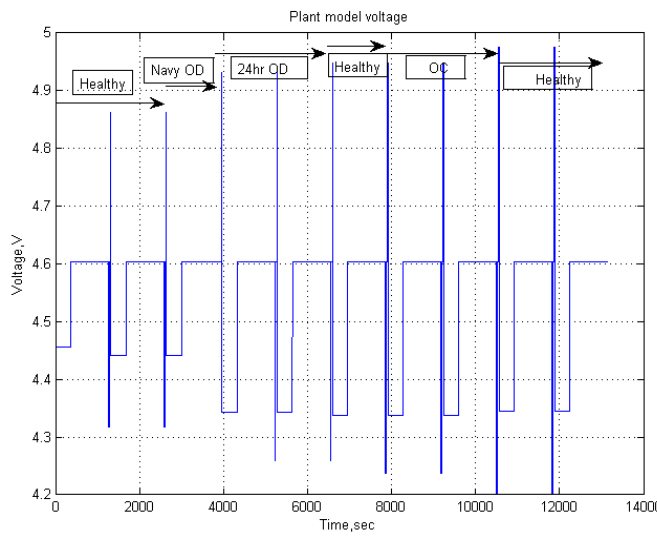
Figure 8. Considered plant model voltage profile.